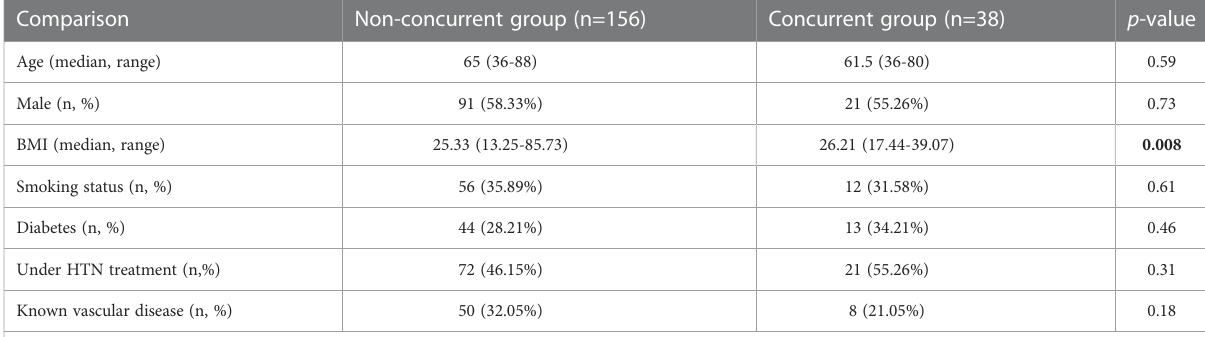
TABLE 5 Baseline patient characteristic comparison between the non-concurrent group and the concurrent group.